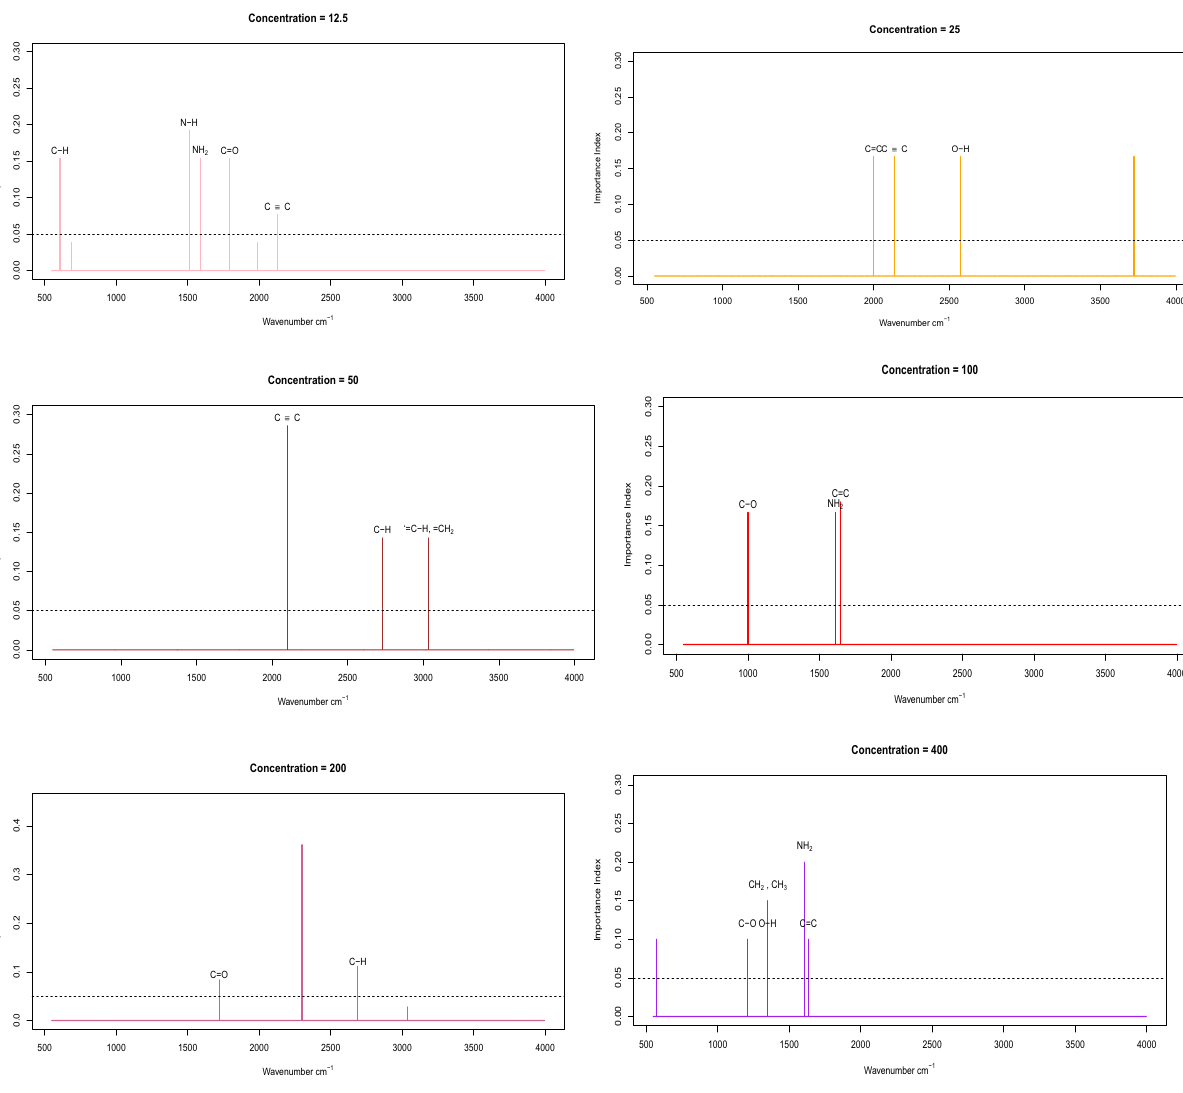
Figure 6. Influential wavenumbers are picked at various concentration levels by the optimal model calculated as shown. Along with a powerful functional group, the relevant regression coefficients of the best suited model are